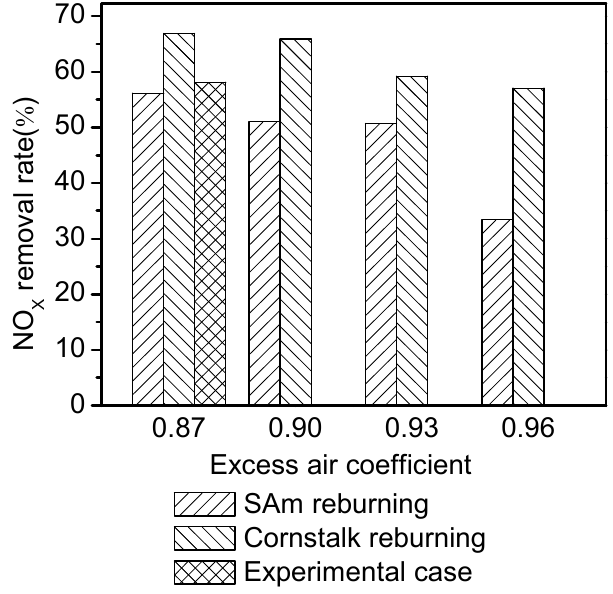
Figure 4. NO x removal rate under different α